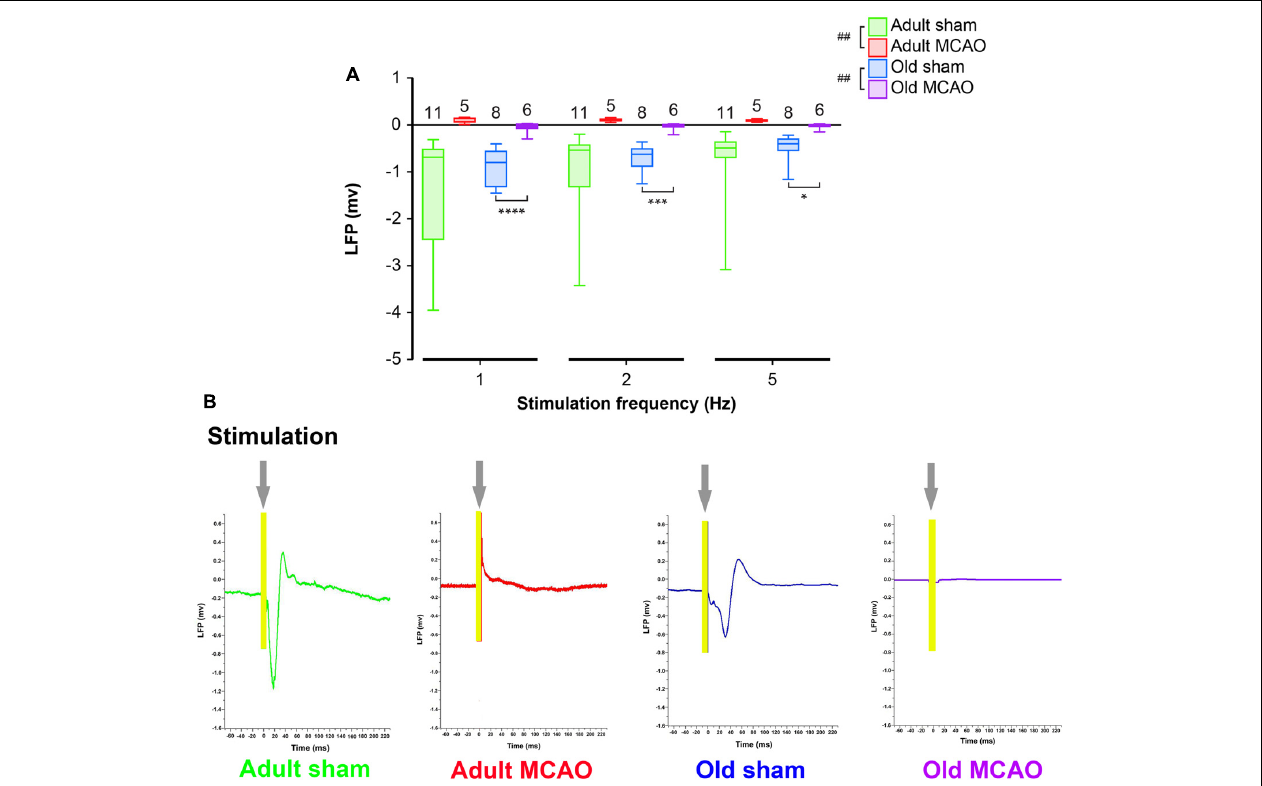
FIGURE 2 | Stroke abolished local field potential (LFP) amplitudes in the penumbra of young and old mice. (A) In old mice, permanent middle cerebral artery occlusion (MCAO) diminished LFP amplitudes at all stimulation frequencies (1 Hz, p < 0.0001; 2 Hz, p = 0.0005; 5 Hz, p = 0.0207). (B) Representative LFP traces from adult and old stroke mice compared to sham controls. Adult and old stroke mice show significantly reduced LFP amplitudes. In the old stroke mice, we observed complete electrical silence. Gray arrows indicate the point at which the stimulation was delivered. The small positivity above the 0 mv axis (as seen in adult MCAO) could be a farfield potential from neighboring active sites. Data are shown as mean ± standard error of mean. Data were analyzed using linear mixed-effects models with Holm-Sidak post hoc tests. ∗ Significant difference between treatments (i.e., experiment conditions). # Significant difference in the interaction (treatment and stimulation frequencies) between experimental conditions. ∗ and # in the legend indicate overall effects, while symbols over bars indicate group difference for an individual stimulation frequency. ∗ p ≤ 0.05, ∗∗ p ≤ 0.01, ∗∗∗ p ≤ 0.001, ∗∗∗∗ p ≤ 0.0001. The numbers of mice are presented over the bars.